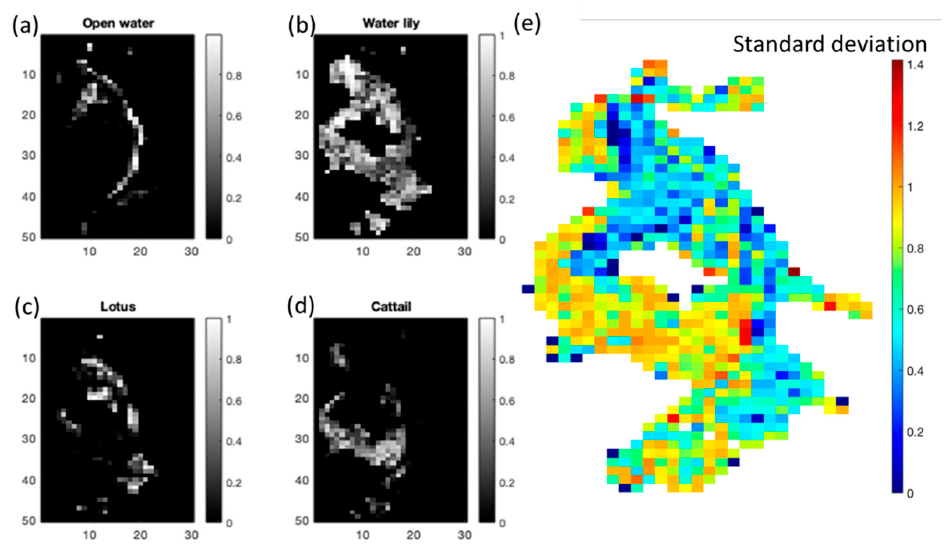
Figure 4. ( a – d ) Fractional cover. For each HLS pixel, the fractional cover indicates the fraction of pixels in the corresponding World-View3 image that are located within that HLS pixel area that are of the patch type that was classified as the HLS majority patch type (i.e., the classified HLS type of that pixel). Panels show results per HLS classified patch type (patch types are listed in panel titles). A fractional cover value of 1 indicates that all the area within the HLS pixel belongs to the classified patch type. A low fractional cover indicates that a large fraction of the area within the HLS pixel belongs to different patch types from the classified majority type. ( a ) Open water, ( b ) water lily, ( c ) lotus, ( d ) cattail. ( e ) Overall patch heterogeneity is represented as the standard deviation of patch types among the World-View3 pixels within each HLS pixel.